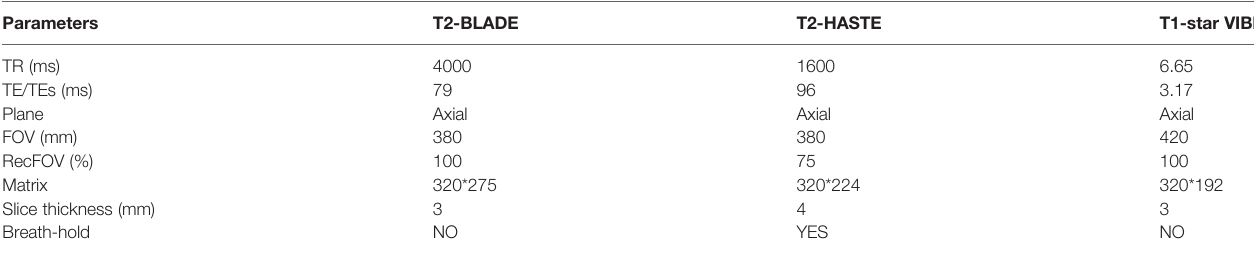
TABLE 1 | Parameters of the applied MRI